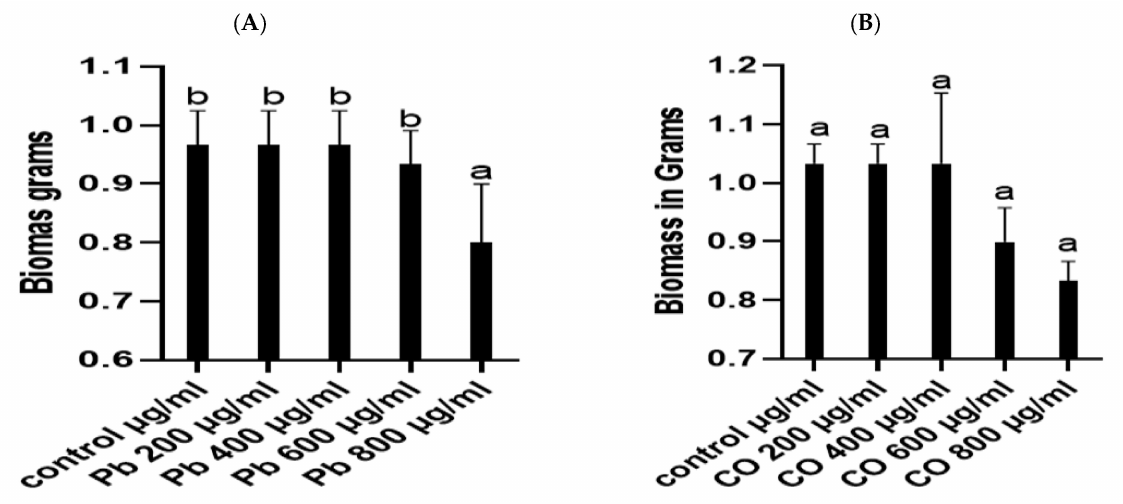
Figure 3. ( A ) Represent weight of fresh biomass of P. lilacinus under lead stress. Bars represents mean of triplicates with ± SE. Alphabets above the bars are different significantly from one another at p ≤ 0.05. ( B ) Represents weight of fresh biomass of P. lilacinus under cobalt stress. Bars represents mean of triplicates with ± SE. Alphabets above the bars are different significantly from one another at p ≤